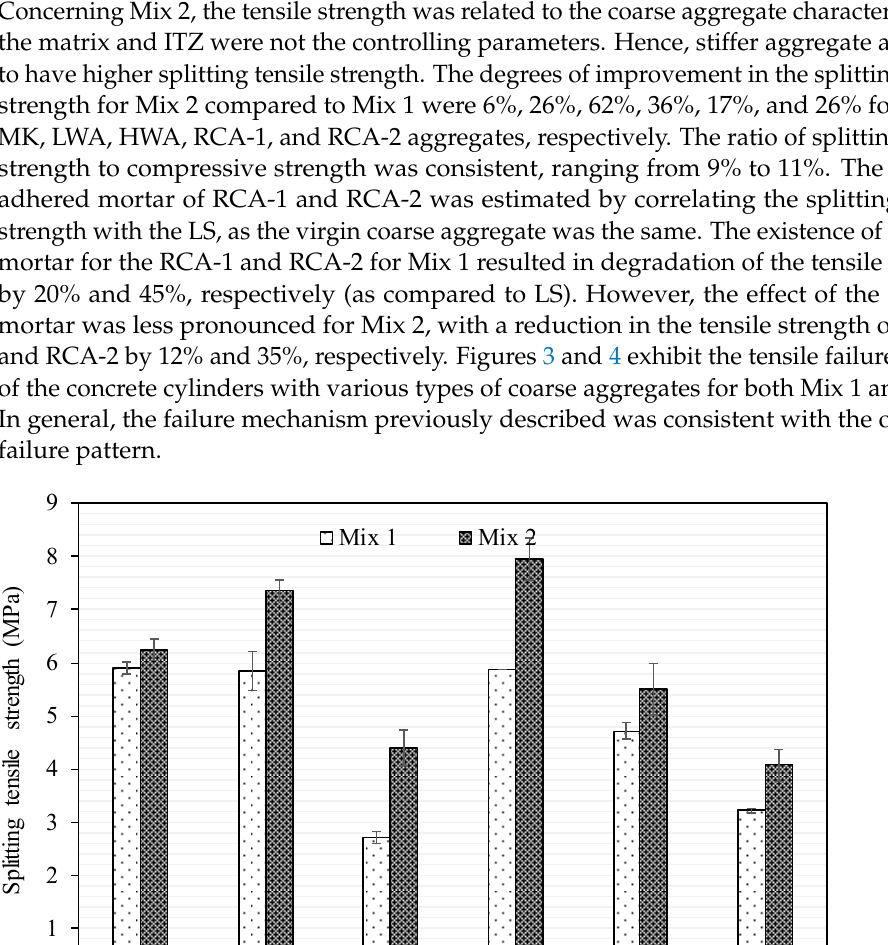
Figure 4. Illustrative photographs of Mix 2: ( a , b ) compression and splitting tension failure; and ( c ) cross section.